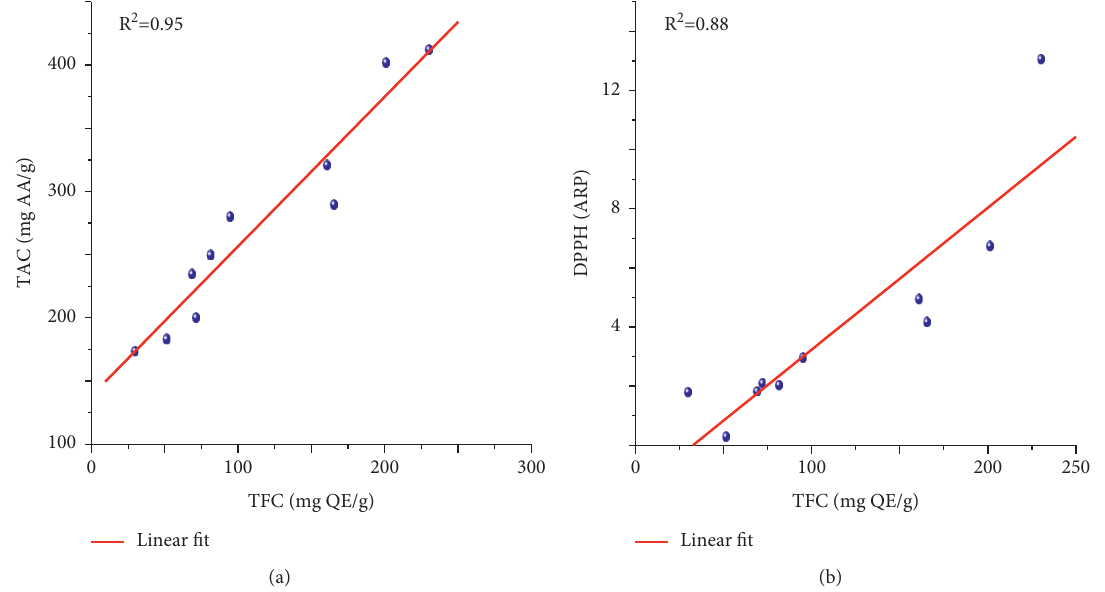
Figure 4: Linear dependency between the antioxidant activity TFC and DPPH